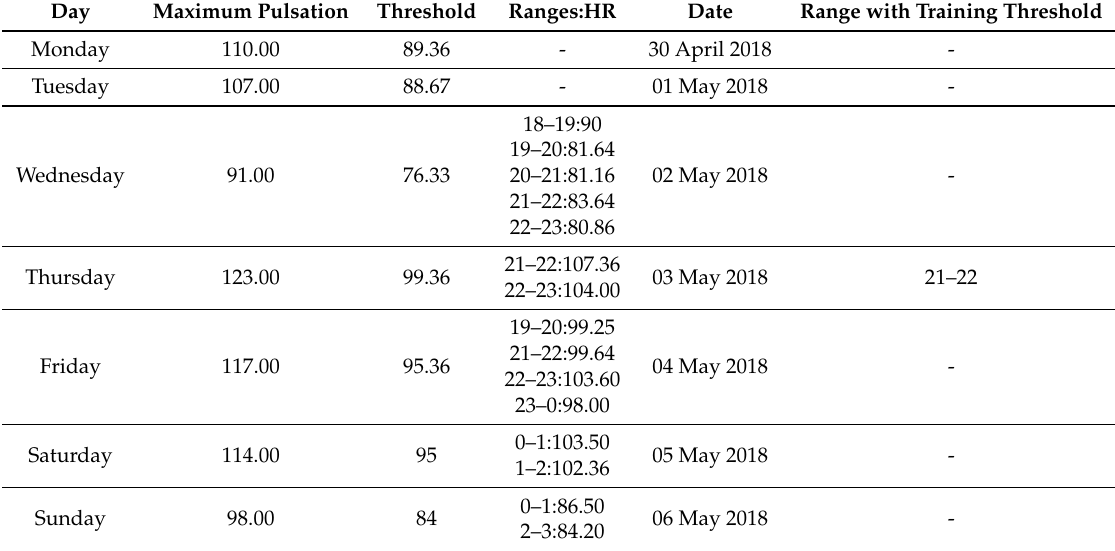
Table 2. Training week 2 from 30 April to 6